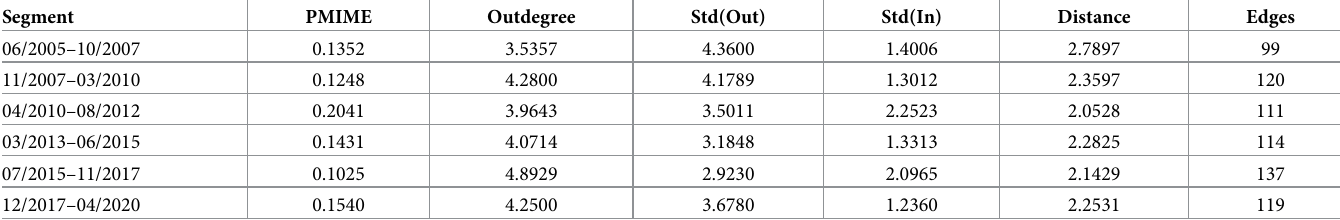
Table 5. Results of industry index over six segments. Segment